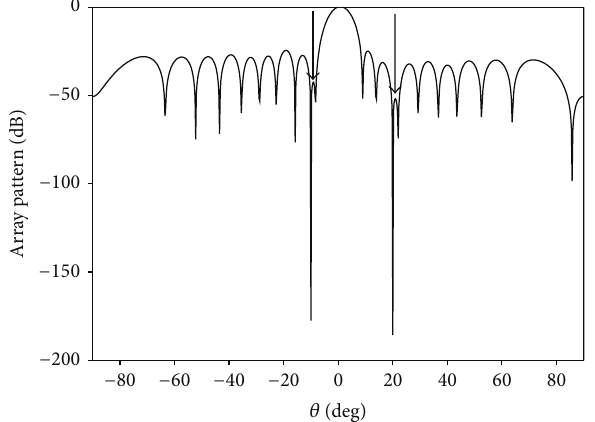
Figure 10: Radiation pattern found by phase only control with double null at − 10 ∘ and 20 ∘ .